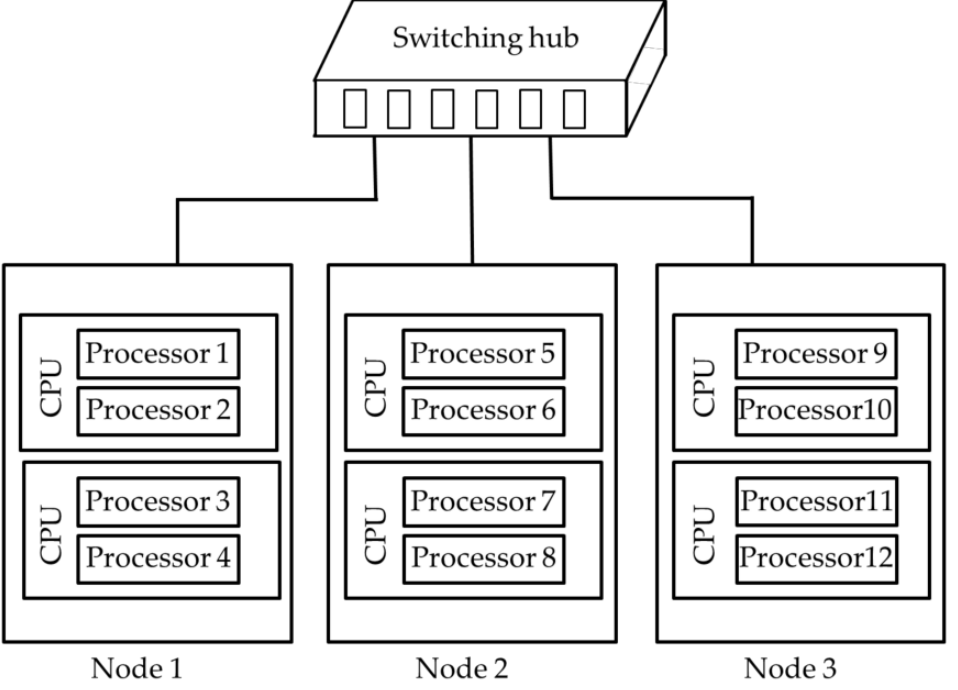
Figure 2. Local network configuration: Three physically separated computers were used. Individual nodes have the same performance in terms of RAM and CPU, and data communication is possible through a switching hub.